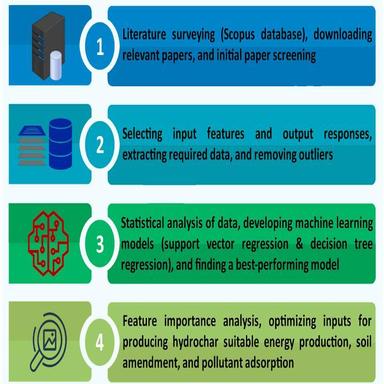
The research method used in this study.